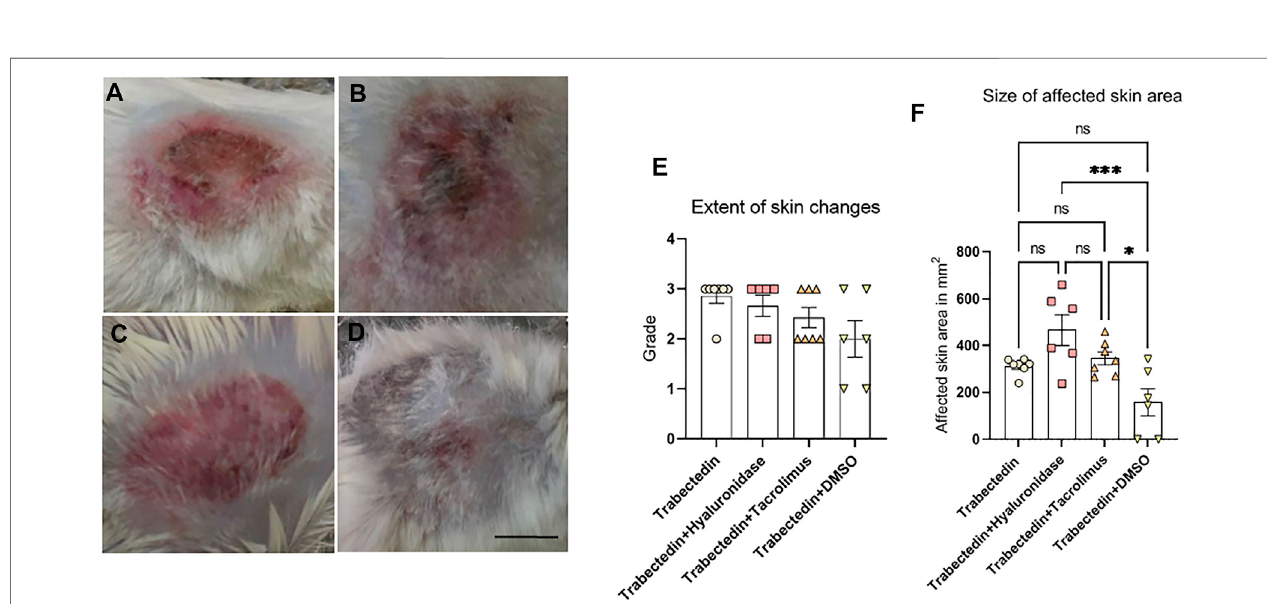
FIGURE3| Representative imagesoftreatedareainmiceatday fi veaftertreatmentwith (A) trabectedin(grade3), (B) trabectedinandhyaluronidase(grade3), (C) trabectedin and tacrolimus (grade 2), (D) trabectedin and DMSO (grade 2). (E) Extent of skin changes assessed by grading. (F) Size of affected skin area in lesions graded at least as grade 2, statistically analyzed using ANOVA followed by a post-hoc test with a Tukey-B correction * p < 0.05, *** p < 0.005, ns = not signi fi cant. Scale bar is 1 cm.